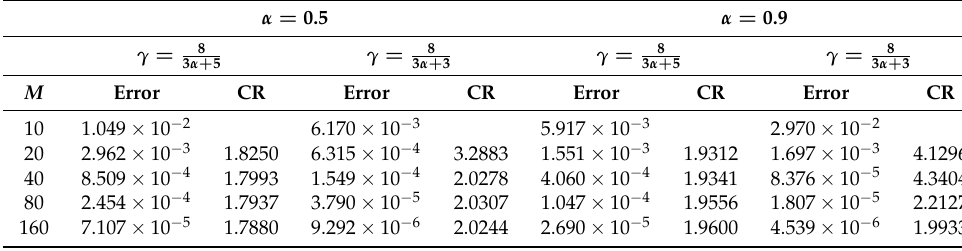
Table 4. g ( u ) = u 3 with β =